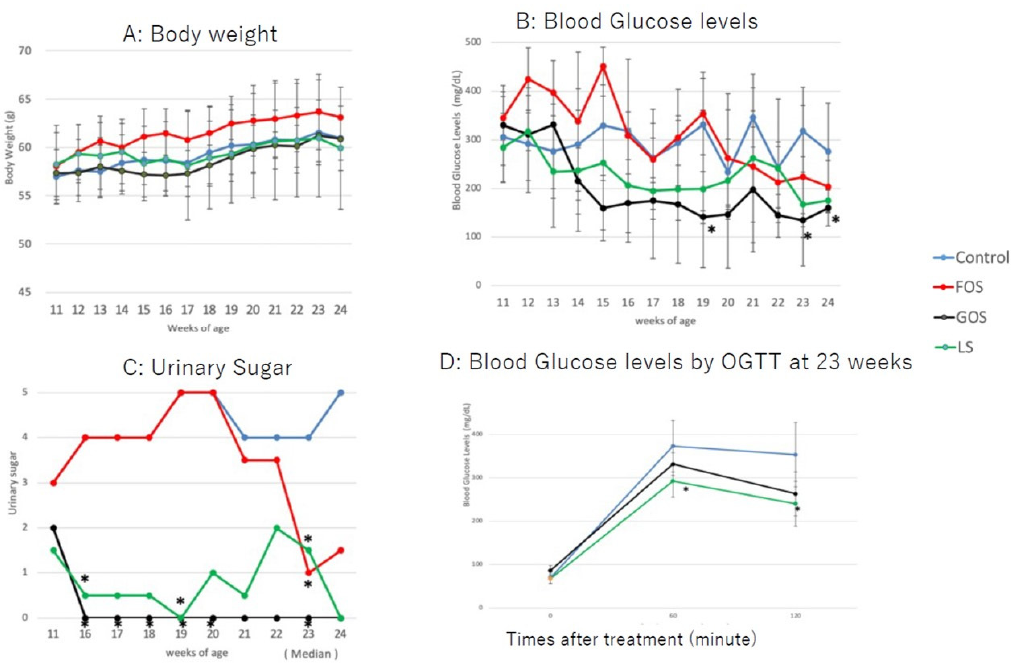
Figure 5. Changes in body weight ( A ), blood glucose level ( B ), and urine glucose ( C ) in the experimental groups. ( D ) Blood glucose levels by OGTT at 23 weeks. Values are expressed as means ± SD. * p < 0.05 vs. control (Dunnett’s post hoc analysis).